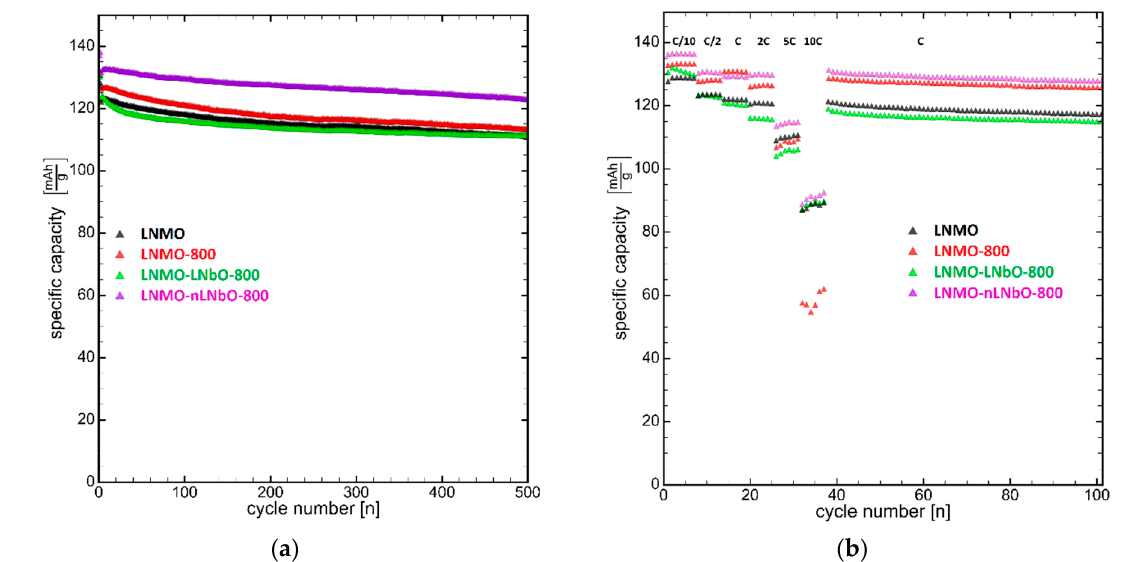
Figure 5. ( a ) Capacity retention test at charge-discharge rate at C/2-C (the first two cycles were done at 0.1 C) and ( b ) rate capability test (the first cycle was done at 0.05 C; charge rate was C/2 without holding the voltage and discharge rates were varied as indicated in the figure) of four samples: bare (LNMO), bare calcined at 800 °C (LNMO-800), coated using sol-gel method (LNMO-LNbO-800) and new method (LNMO-nLNbO-800) and calcined at 800 °C.